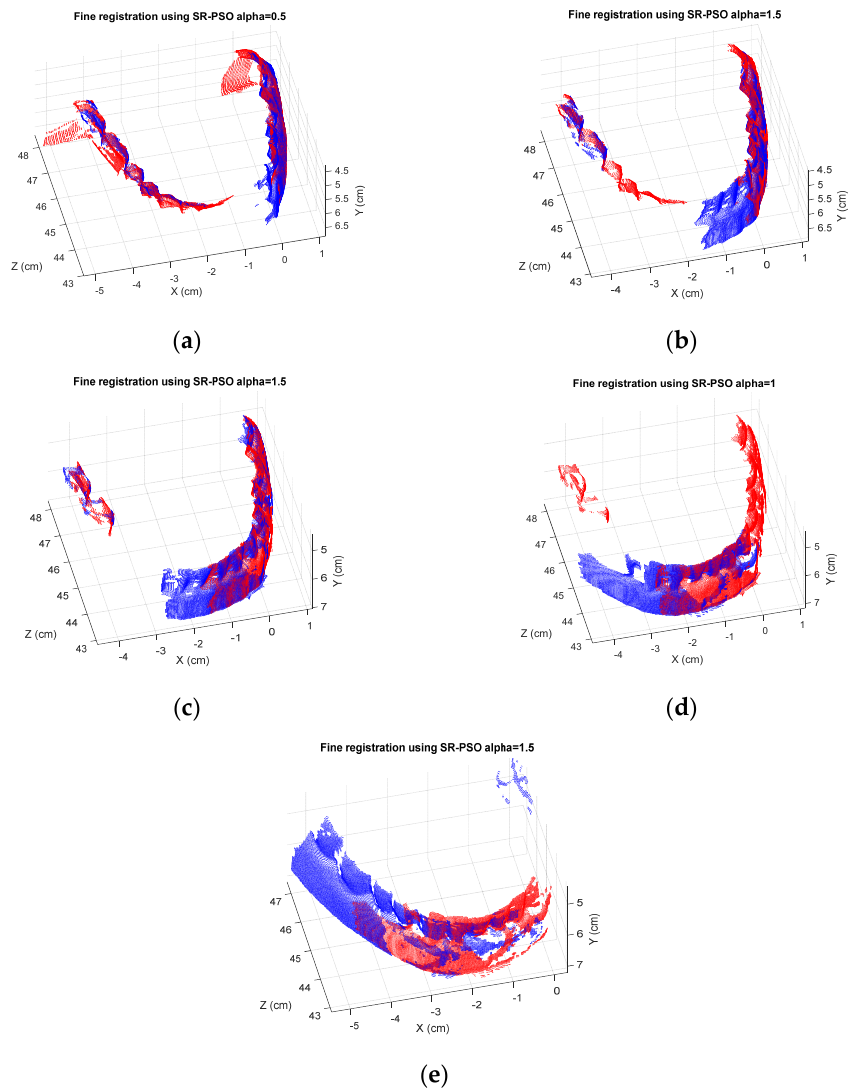
Figure 10. The best SR-PSO with the ICP registration results for the pairs ( a ) 1 and 2; ( b ) 2 and 3; ( c ) 3 and 4; ( d ) 4 and 5; ( e ) 5 and 6 of the regular-tooth model. Table 7. MSE of the final registration of six consecutive views (micrometer 2 ) for the regular-tooth model (the best value is in bold). SR-PSO with ICP PSO with